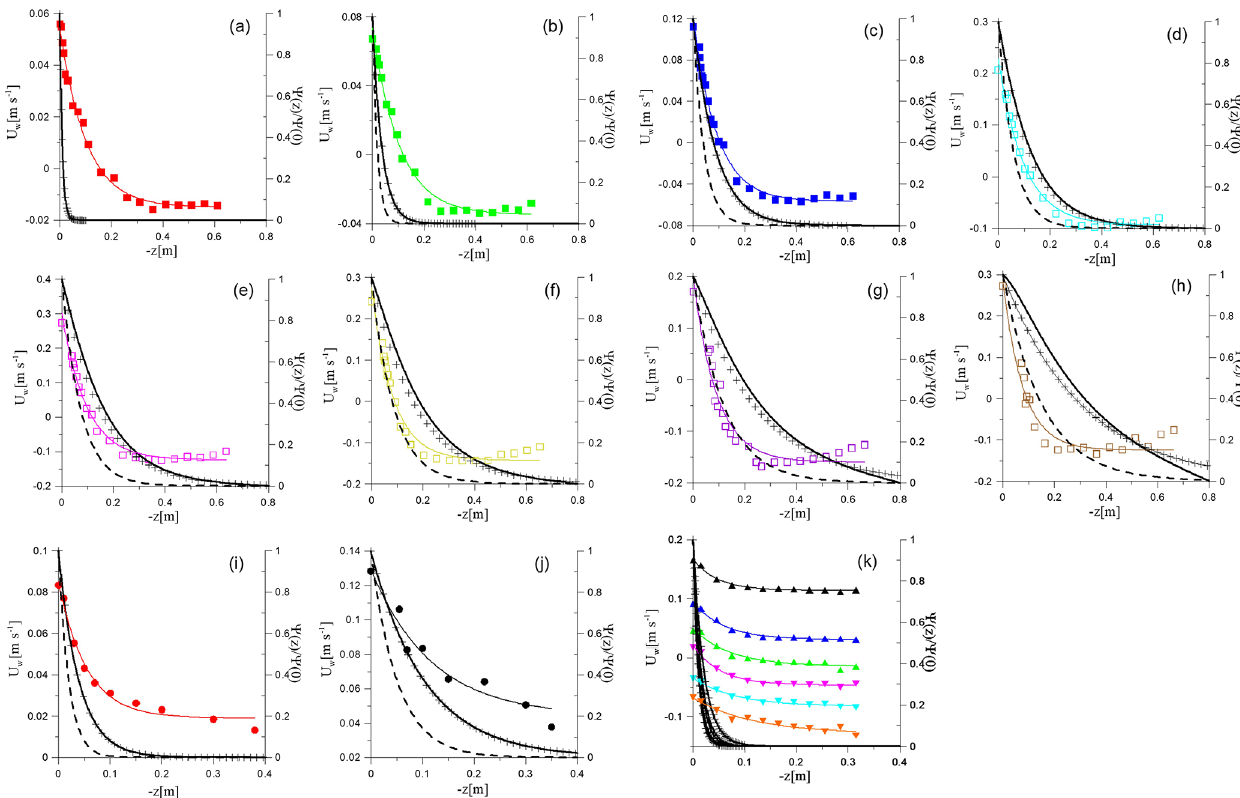
Figure 8. Vertical velocity profiles (points), their fitting (thin colored line), the eigenfunction of Eq. (8) with the boundary conditions in Eq. (9) (black solid curve), the function e kz (crosses), and the function e 2 kz (dashed line). Panels (a) – (j) correspond to experiment nos. 1, 3, 5, 7, 9, 11, 13–15, and 18, respectively, and (k) corresponds to experiment nos.